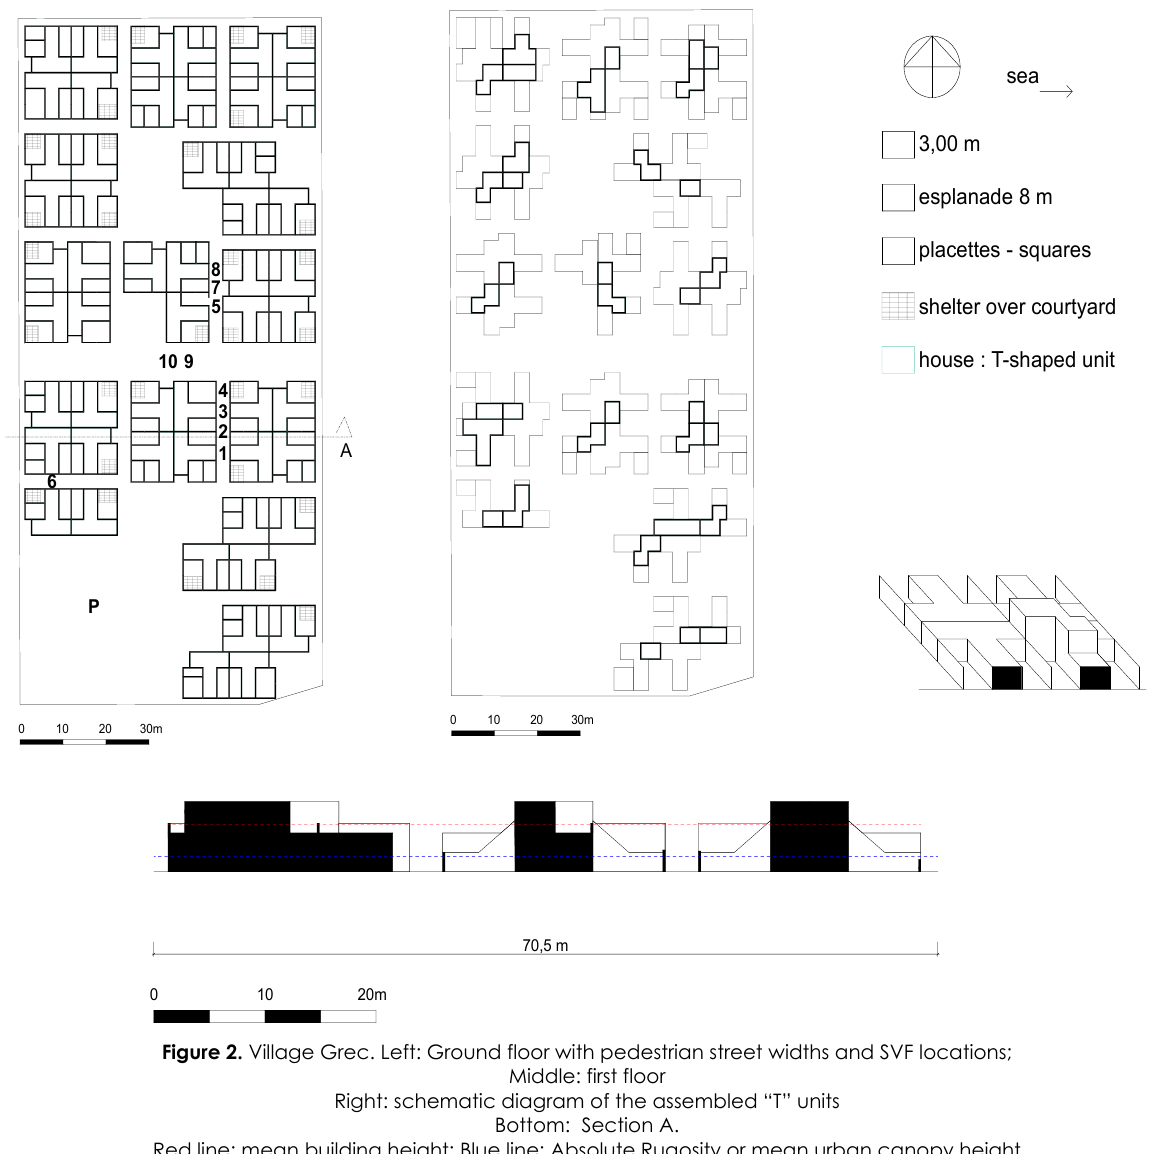
Figure 2. Village Grec. Left: Ground floor with pedestrian street widths and SVF locations; Middle: first floor Right: schematic diagram of the assembled “T” units Bottom: Section A. Red line: mean building height; Blue line: Absolute Rugosity or mean urban canopy